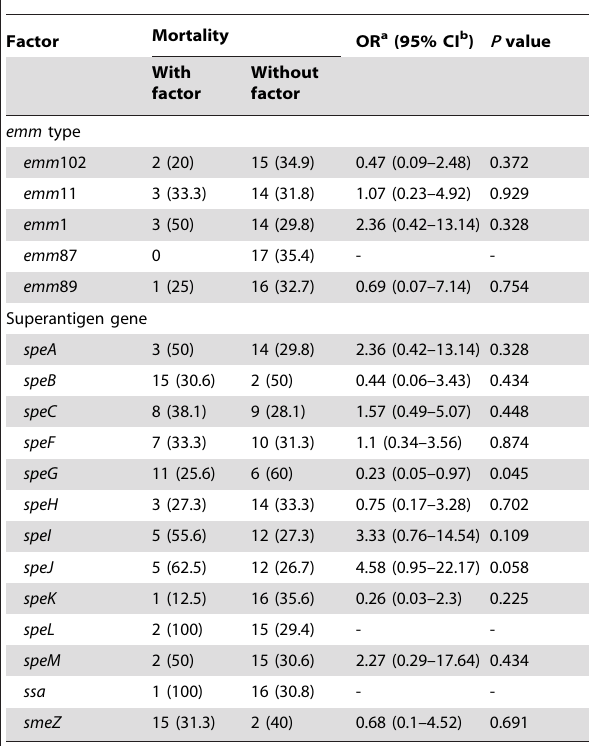
Table 4. Association between emm Types and Superantigen Genes of Streptococcus pyogenes and Mortality in Toxic Shock Syndrome.